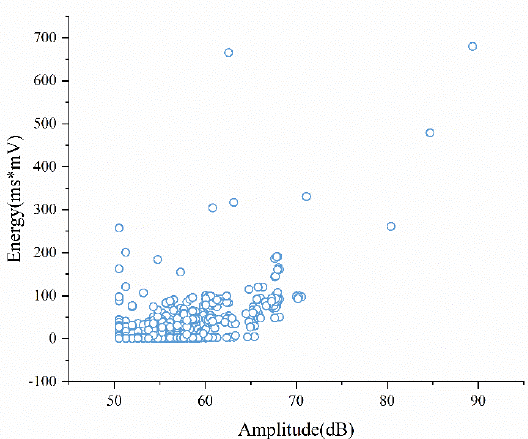
Figure 16. Amplitude-energy correlation diagram of cable noise signal of Caihong Bridge.